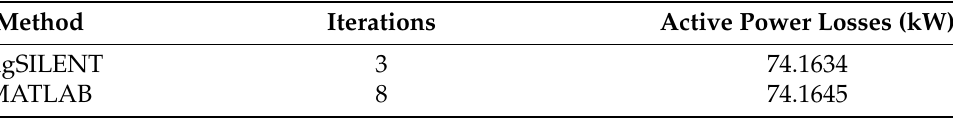
Table 4. Performance of the power-flow methods.